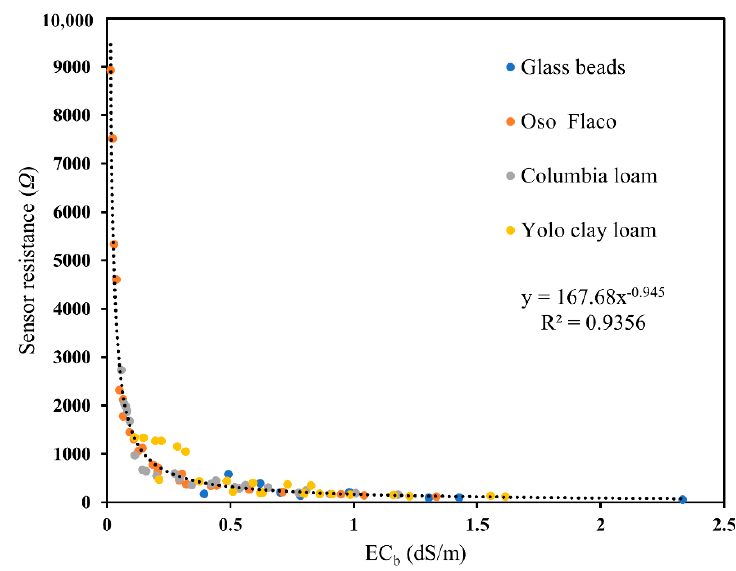
Figure 6. Response of the sensor to temperature at each actual water content and ( a ) at ~0.5 dS/m salinity, and ( b ) at 1 dS/m salinity in glass beads. Sensor data represents the raw data in resistance ( 𝛺 ) at different temperatures.